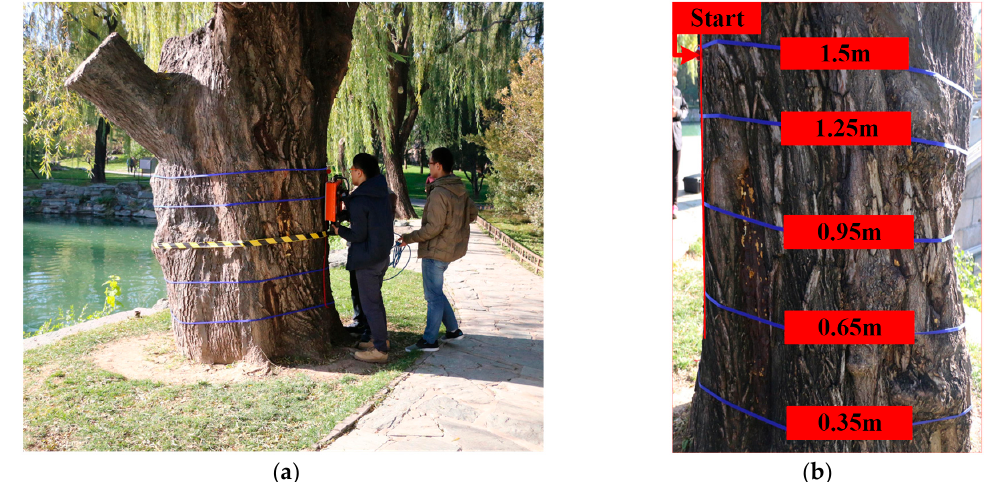
Figure 8. The investigated tree at the Summer Palace, Beijing, China. ( a ) Actual detection of irregular trunks. ( b ) Different heights of irregular tree